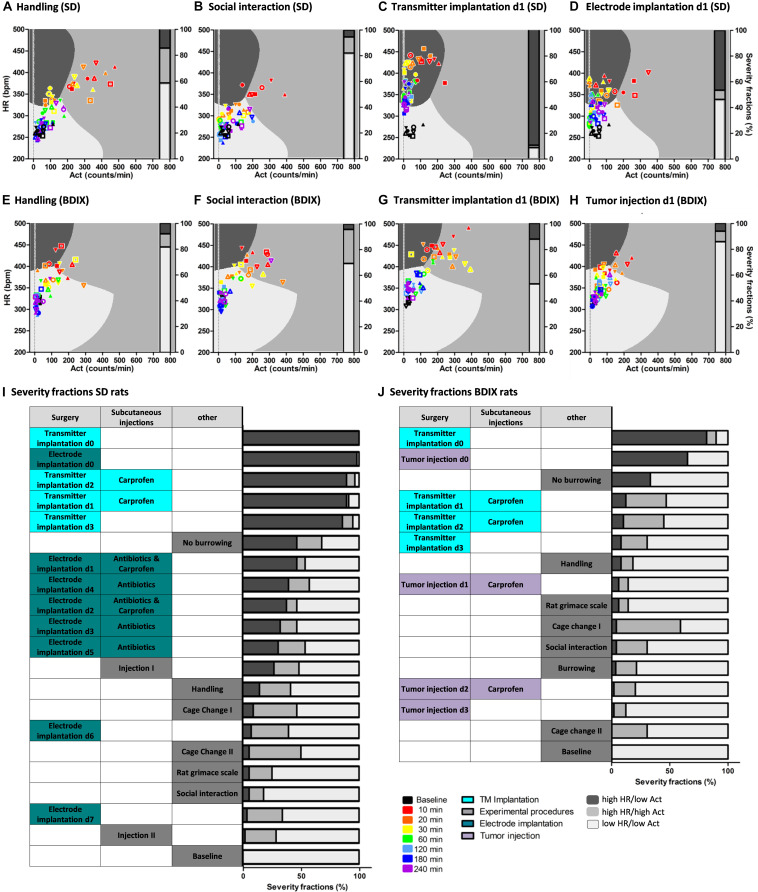
Evaluation of SVM as tool to classify severity. Exemplarily validation data plotted on SVM decision boundaries (A–H): handling [(A) SD rats, (E) BDIX rats], social interaction [(B) SD rats, (F) BDIX rats], transmitter implantation d1 [(C) SD rats, (G) BDIX rats], electrode implantation d1 in SD rats (D), and tumor injection in BDIX rats (H). HR (HR; bpm) is shown as mean, and activity (Act; counts/min) is shown as sum over 10 min starting at the indicated time points (color coded) after the experimental procedure. Symbols indicate different individual animals. Three classes were identified by SVM: high HR/low Act (dark gray), high HR/high Act (midgray), low HR/low Act (light gray). Bars indicate fractions of data points allocated to different classes. Ranking of all experimental procedures according to the fraction of data points allocated to the high HR/low Act class [(I) SD rats, (J) BDIX rats].